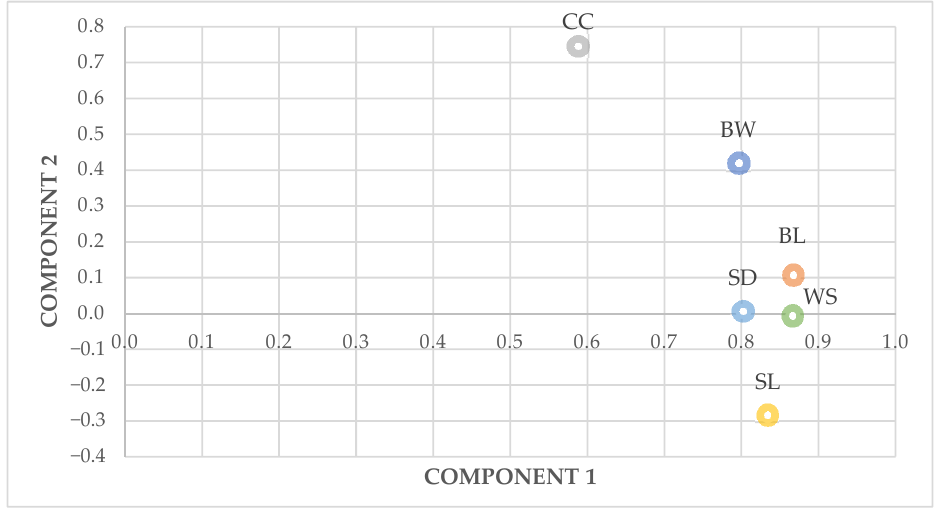
Figure 1. Principal Component Analysis of the zoometric measures in fowls. BW: body weight; BL: body length; CC: chest circumference; SL: shank length; SD: shank diameter; WS: wingspan. In males, two principal components were extracted with eigenvalues of 3.321 and 0.878 for PC1 and PC2, respectively and accounted for 69.9% of the total variance present in the original variables. PC1 had high positive loadings on body length (0.835), wingspan (0.809) and body weight (0.783). PC2 most highly correlated with shank length (0.844) (Figure 2).